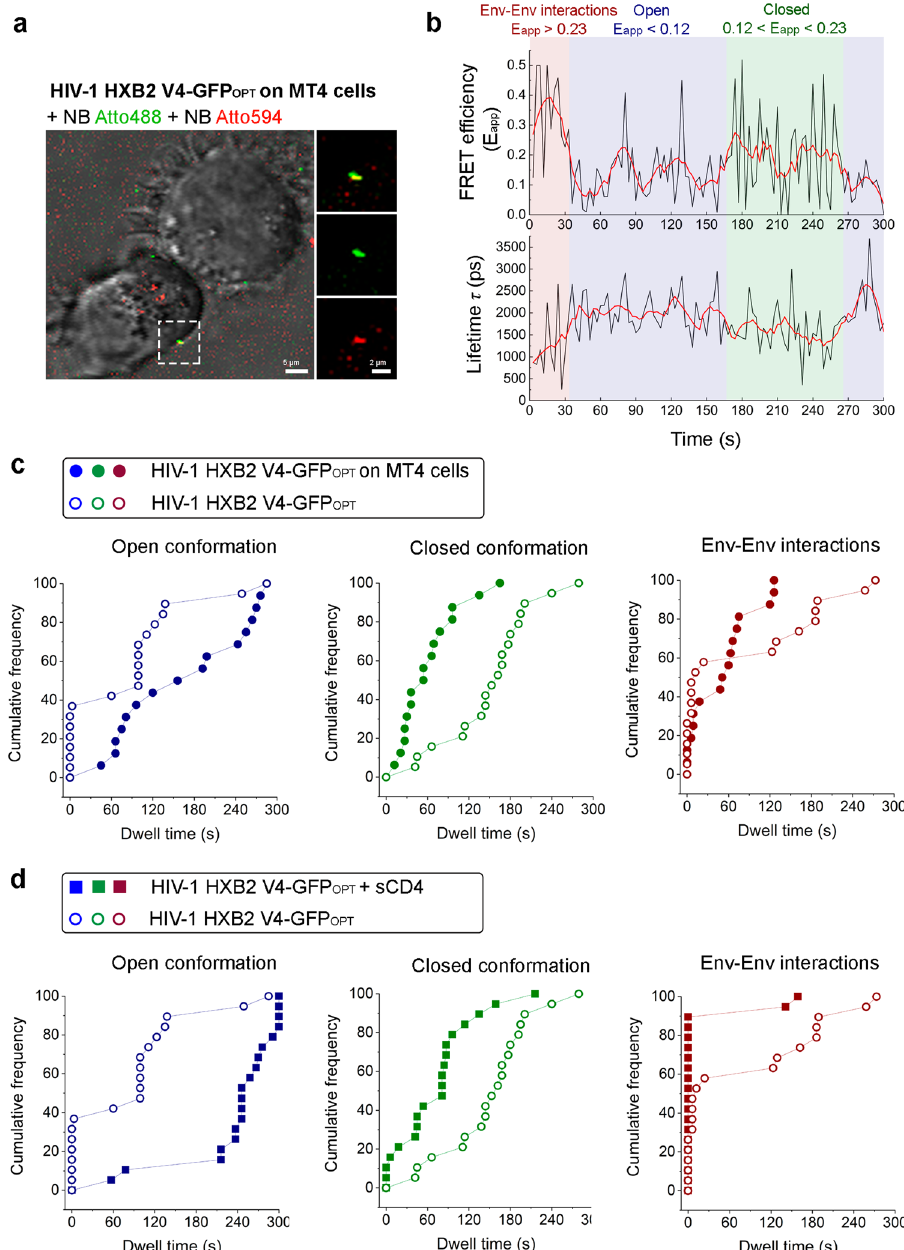
Fig. 3 HIV-1 Env cluster is destabilized when engaged in the pre-fusion reaction in live T cells. a Micrograph showing mature HIV-1 HXB2 V4-GFP OPT virions labelled with NbA488 (green) NbA594 (red) engaged in the pre-fusion reaction onto living MT4 T cells (phase contrast). The scale bar image on the left is 5 µ m. Magni fi cation of the region contoured with dashed lines is shown on the right. Viral particle showing colocalization between green and red channels is shown on the upper right panel. The middle and bottom-right panels correspond to the same viral particle as observed in green and red channels, respectively. Scale bar magni fi cation is 2 µ m. b Graphs represent FRET ef fi ciency (E app ) and lifetime (in ps) traces over time. High FRET ef fi ciency burst (E app >0.23), de fi ning intermolecular interactions is depicted in red; intermediate FRET ef fi ciency regime (0.12<E app <0.23) assigned to closed Env conformations is depicted in green, and low FRET ef fi ciency bursts (E app <0.12) reporting open Env conformations is depicted in blue. Note that high FRET ef fi ciency correlates with low lifetime values and vice versa. c Cumulative Distribution Functions (CDF) are plotted for E app single traces obtained from at least ( n = 20) HIV-1 HXB2 V4-GFP OPT virions in vitro (open dots) and in presence of living T cells (solid dots). Each FRET regime determines the Env conformational state/Env distribution and kinetics. d Analysis as in ( c ) of HIV-1 HXB2 V4-GFP OPT virions in vitro (open dots) and in presence of sCD4 (solid